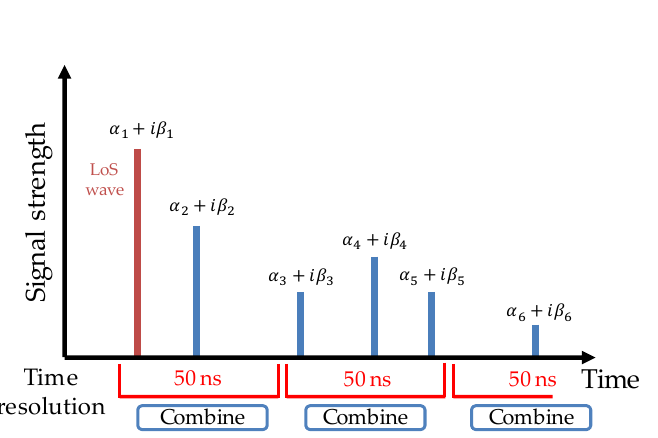
Figure 8. Simulation of time resolution.